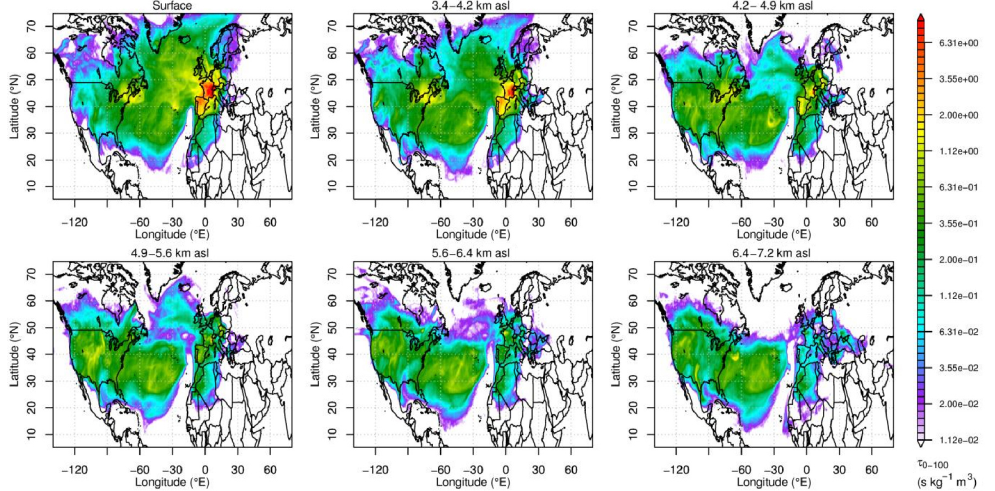
Figure 6. Surface source sensitivity (footprints) of the air masses at JFJ (surface in situ) and in the sub-columns above JFJ in August (CO 2 minimum of FTIR and NDIR time series) in the period 2009 to 2011 simulated with FLEXPART. The height of the sub-columns is given above the according subplots, the x axis is the longitude, the y axis represents the latitude, the color code of the sensitivity is given at the right